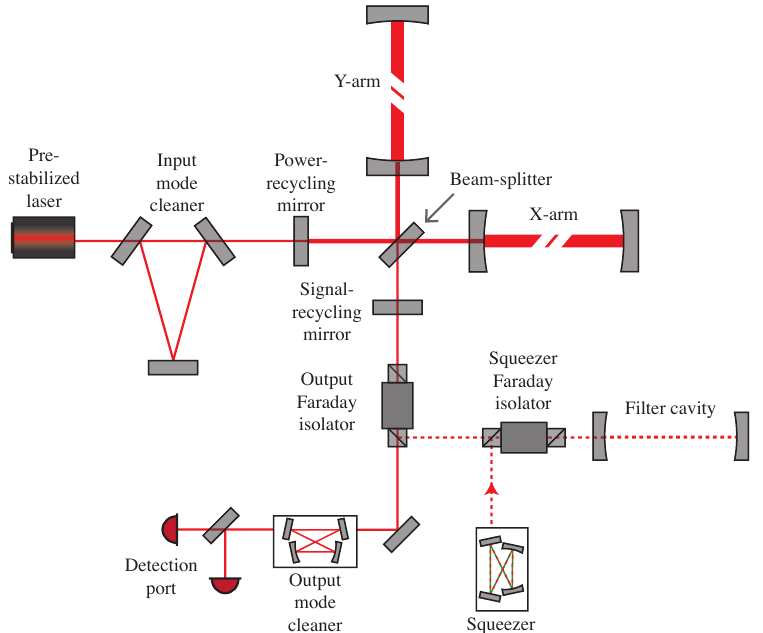
Figure 1. Simplified optical layout of the LIGO detectors for the fourth observing run. The pre- stabilized laser first traverses the input mode cleaner to further stabilize the laser light before entering the main interferometer. The main interferometer consists of the seven core optics in the upper right, including the Fabry–Pérot arm cavities, 50:50 beamsplitter, and recycling mirrors. The GW signal from the main interferometer (solid red) transmits through the signal-recycling mirror, output Faraday isolator, and output mode cleaner to the detection photodetectors at the detection (or antisymmetric) port. The dashed red represents the squeezed light input path from the squeezer cavity, reflected off the filter cavity, and input on the back of the signal-recycling mirror. The filter cavity is discussed in Section